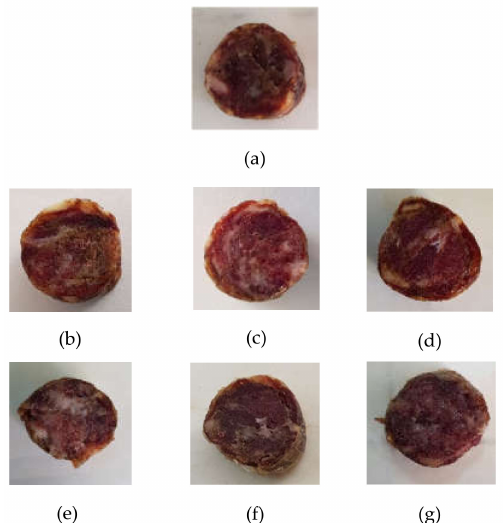
(Figure 1). Lightness ( L* ), redness ( a* ), and yellowness ( b* ) were significantly linked to the addition of NO ( p < 0.001, p < 0.001 and p = 0.025, respectively). Furthermore, yellowness ( b* ) was also influenced by the OLE variable ( p < 0.001).